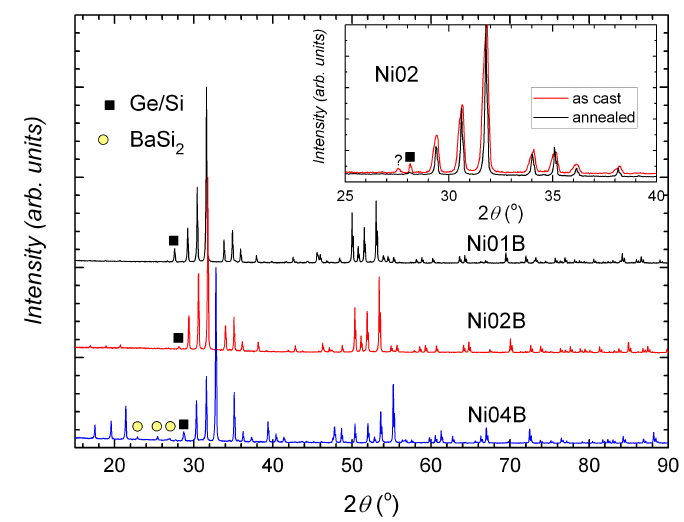
Figure 1. XPD patterns of annealed samples Ni01B, Ni02B, and Ni04B. Different tiny phases can be seen in the annealed samples. Inset: XPD patterns of Ni02A (as cast) and Ni02B (annealed). The annealed sample has very narrow peaks and a small amount of secondary phase (Si/Ge).